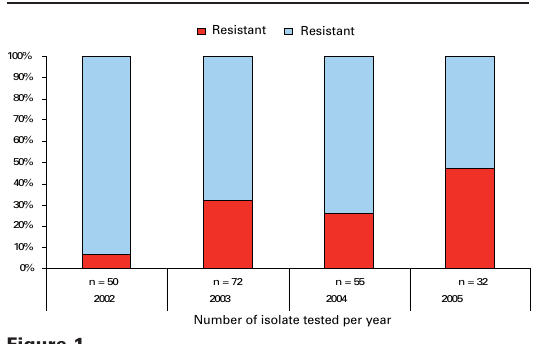
Figure 1 Percentage of isolates susceptible and resistant to ciprofloxacin among Neisseria gonorrhoeae cases. Geneva, January 2002 – October 2005.